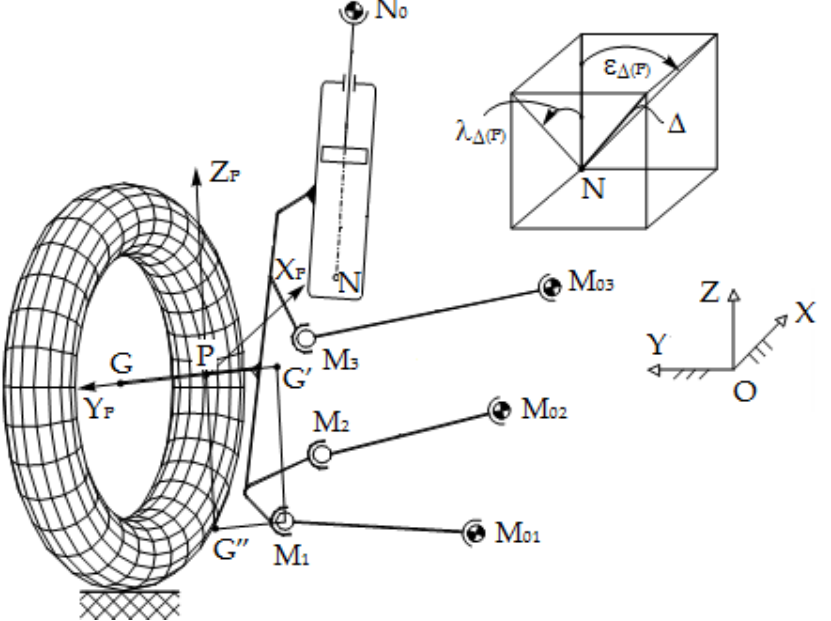
Figure 5. The wheel guidance mechanism based on the McPherson setup.